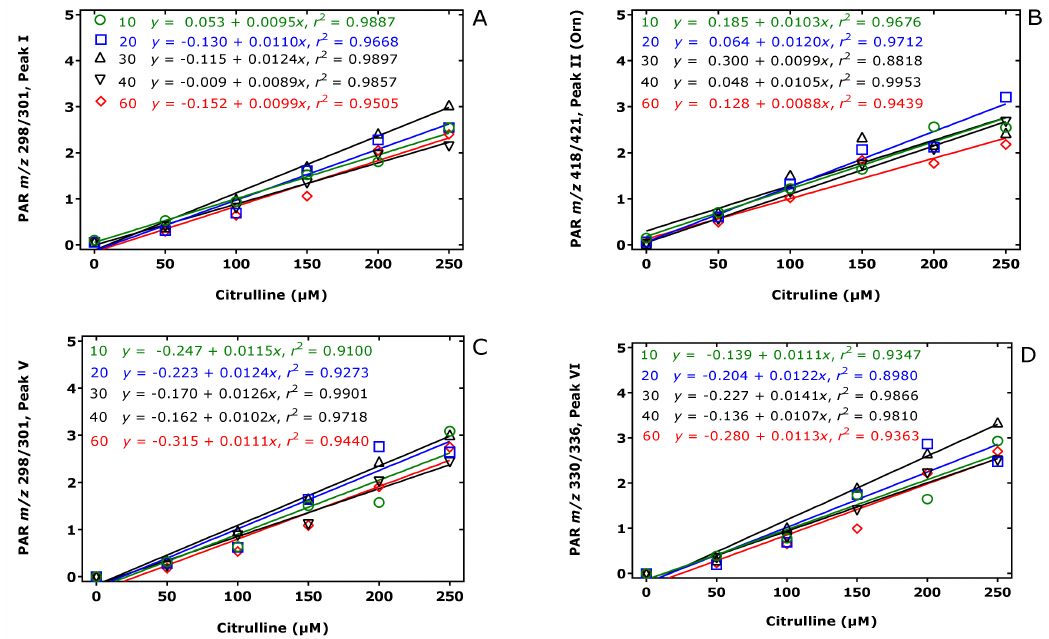
Figure 4. Linear regression analysis between the peak area ratio (PAR) values ( y ) for ( A ) Peak I, ( B ) Peak II, ( C ) Peak V, and ( D ) Peak VI to the corresponding internal standards (generated from 100 µ M Cit) and the Cit concentration ( x ) upon derivatization of aqueous Cit (0, 50, 100, 150, 200, 250 µ M) first with PFPA/EA for a fixed time of 30 min at 65 ◦ C and subsequently with 2 M HCl/CH 3 OH (2 M HCl/CD 3 OD for the internal standard) at 80 ◦ C for 10 (green circles), 20 (blue squares), 30 (black upper triangles), 40 (black lower triangles), 60 (red diamonds) min. Insets indicate the regression equations. Note that Peak II corresponds to the Orn derivative. See also Table 1 and Figure